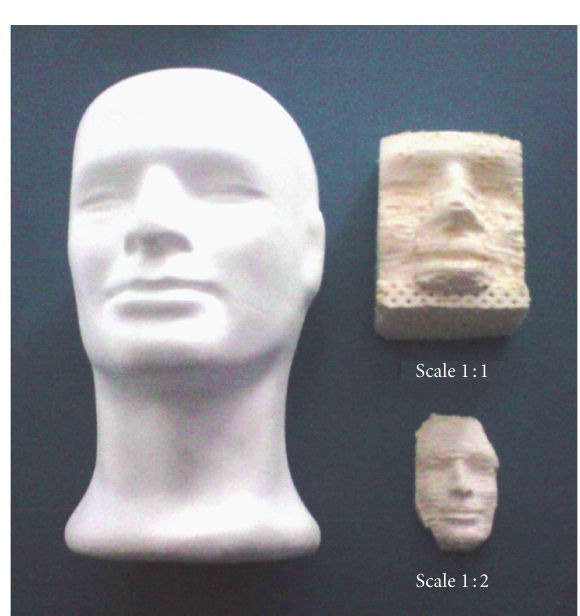
Figure 17: Reproduction of the second test specimen: mock-up